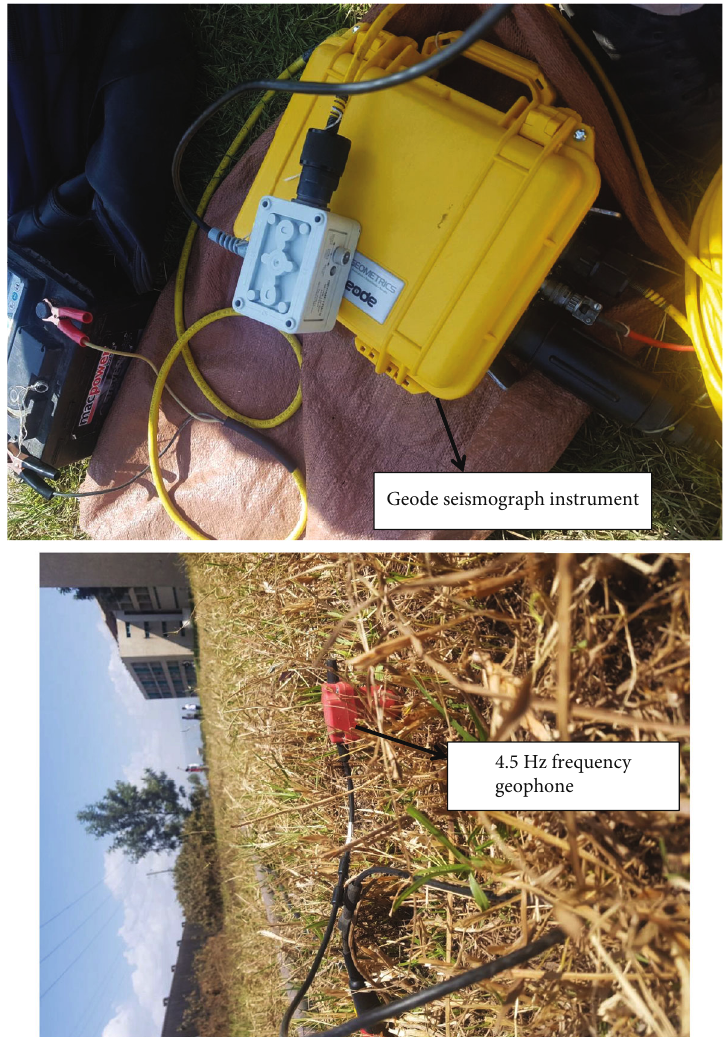
Figure 3: Data acquisition using Geode seismograph instrument in the fi